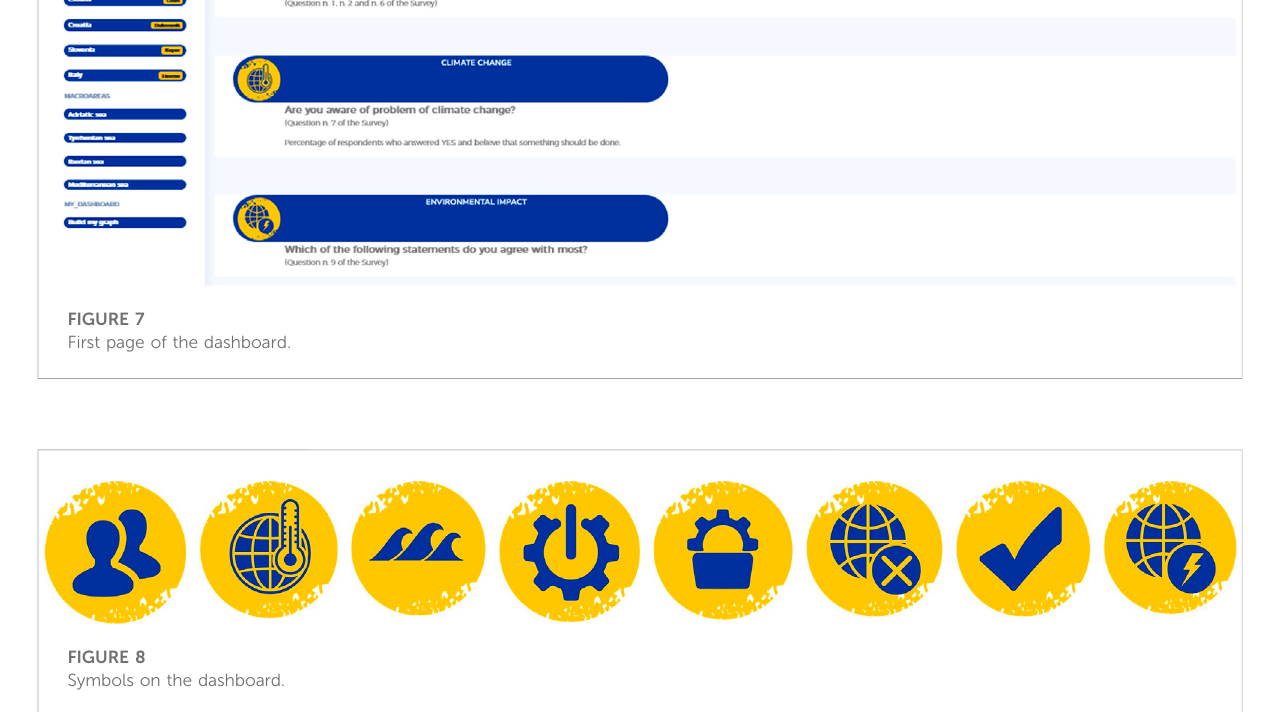
FIGURE 8 Symbols on the